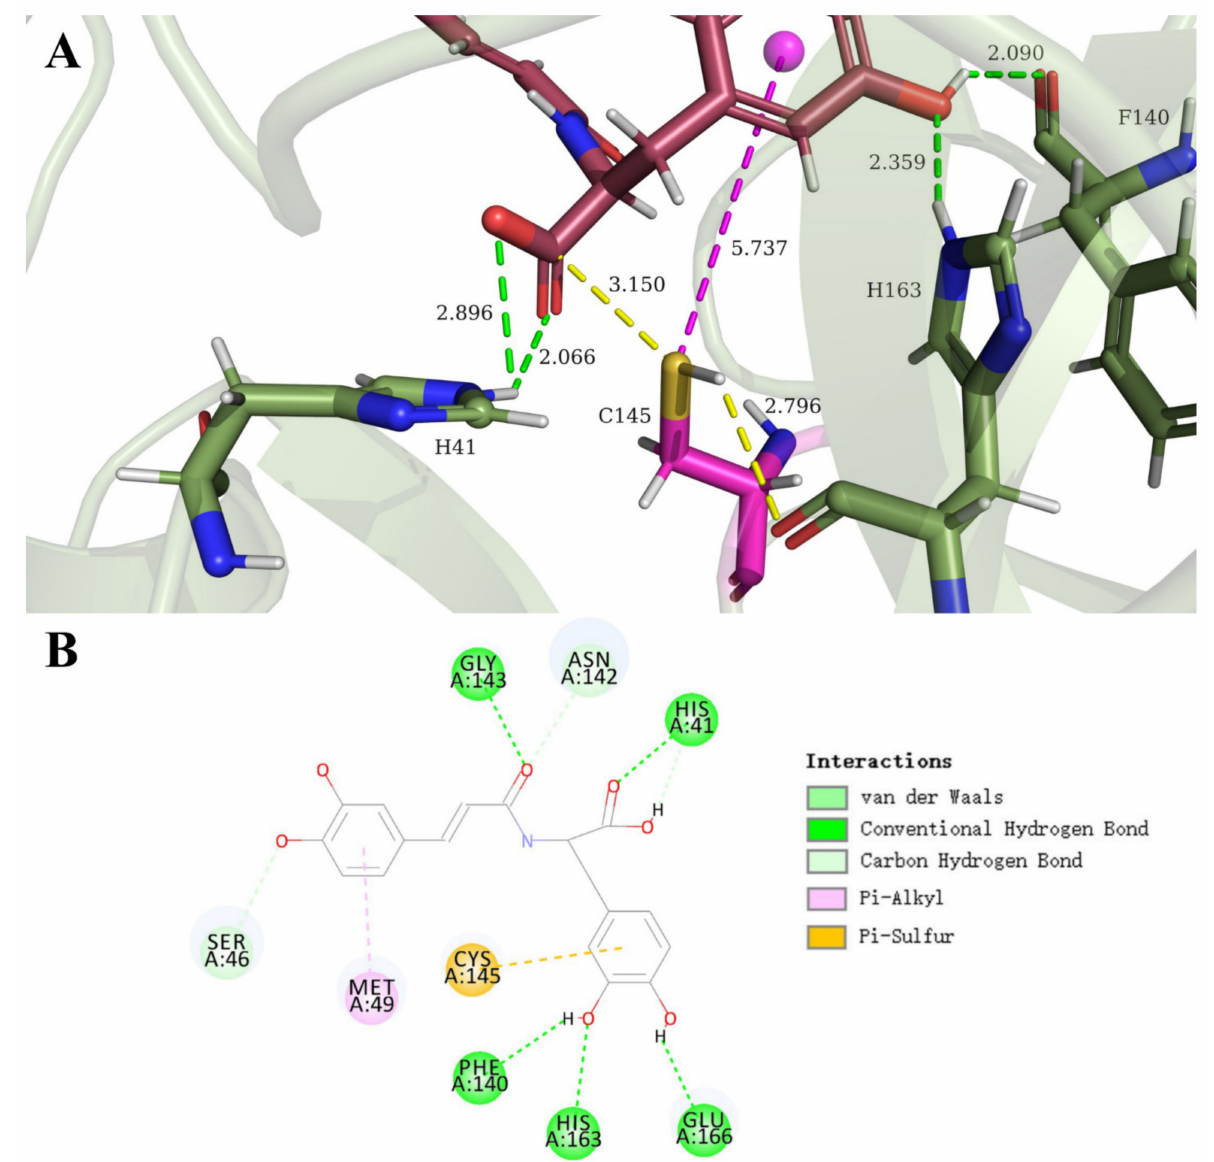
Figure 7. ( A ) Result of docking study pose 12 between clovamide molecule and M pro . In this conformation, the C145 residue would first be deprotonated by backbone O(H163), followed by its nucleophilic attack to the carboxylate carbonyl carbon of the clovamide molecule. The initial step of the thioesterification reaction involves protonation of the carboxylate carbonyl oxygen, which could also be assisted by possible hydrogen bonds as shown, making the group a stronger electrophile to be attacked by C145 thiolate ion. Yellow dash lines are two interatomic distances critical to the inhibitory mechanism; green dash lines represent hydrogen bonds; the magenta line indicates that the distance between C145 and the centroid of the catechol ring (5.737 Å) determines that no inhibitory reactions are favored at the catechol moiety. ( B ) Teo-dimensional display of non-covalent interactions between M pro and clovamide molecule docking pose